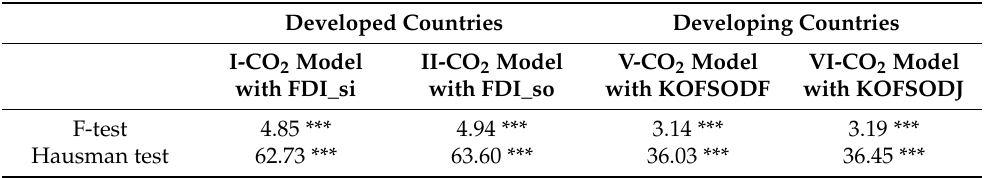
Table A1. Hausman test and F-test for CO 2 model (2000–2017).